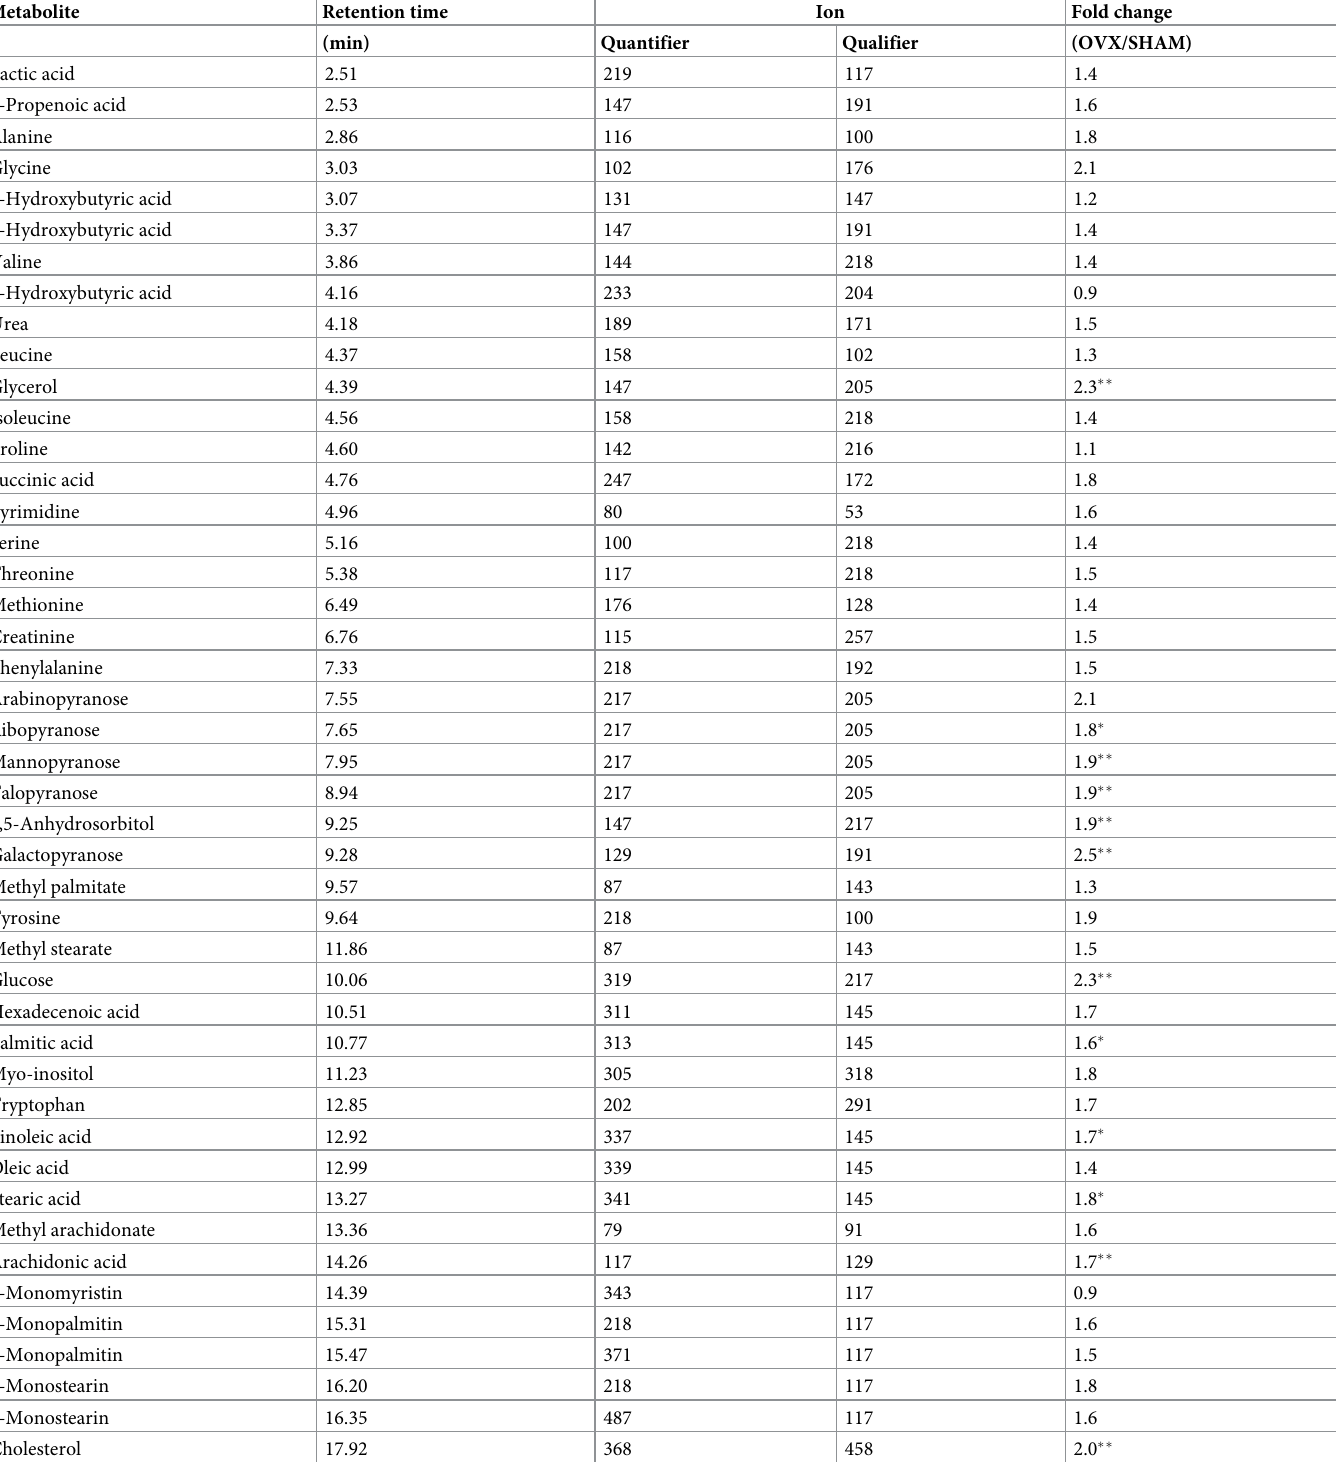
Table 1. GC–MS retention time, quantifier and qualifier ions, and relative peak area of metabolites in ovariectomized (OVX) compared to sham-operated (SHAM) rat